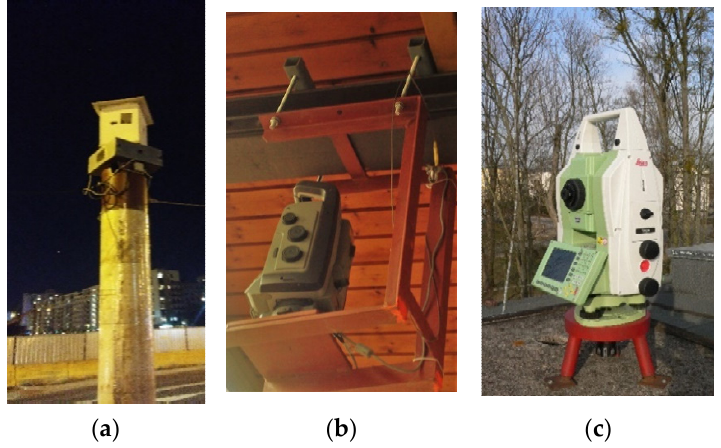
Figure 1. Example view of total station standpoints; ( a ) protected box with aiming holes placed on the top of a concrete pillar, ( b ) attached to an original grip, ( c ) fixed centering on a metal tripod.